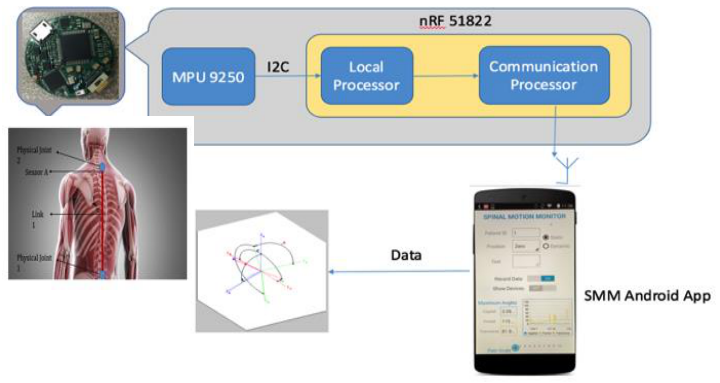
Figure 1. San Diego State University wearable wireless motion sensor network.